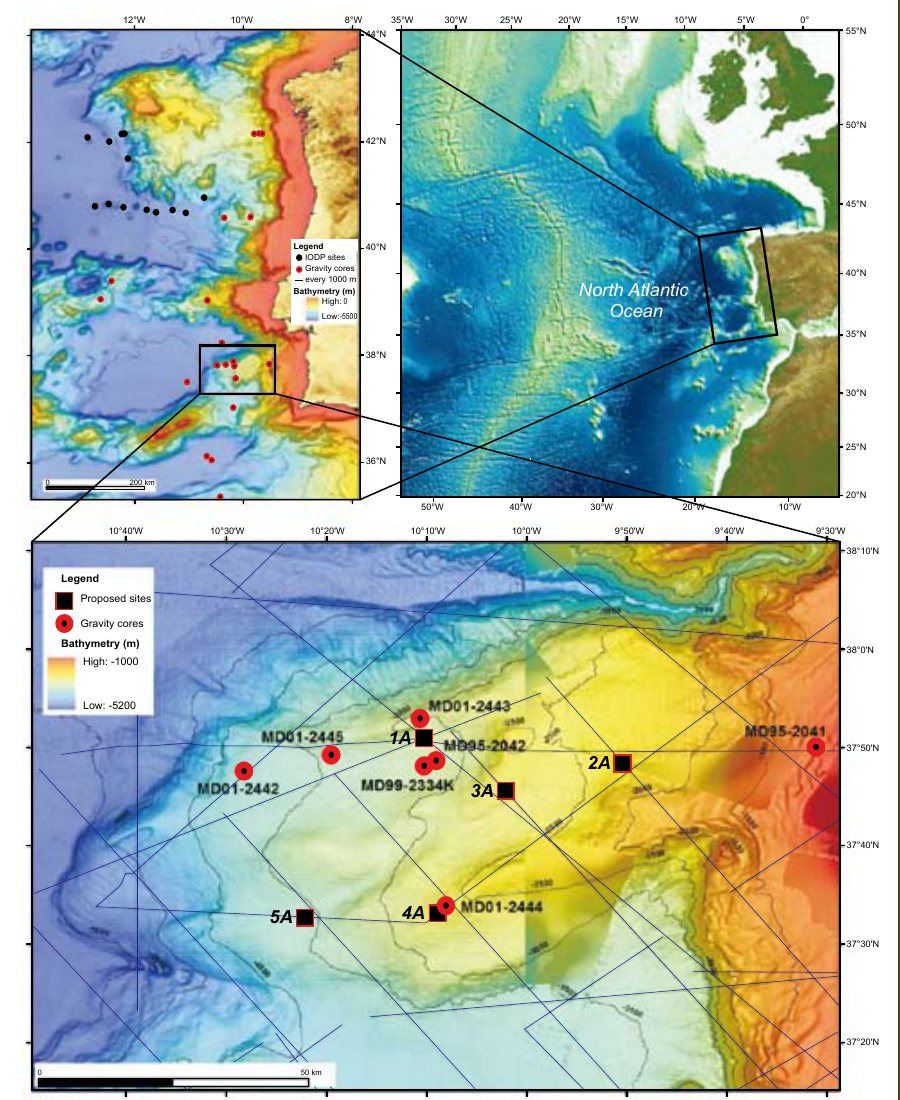
Figure 1. Locations of existing seismic lines, previously collected cores (“Shackleton sites”), and proposed site